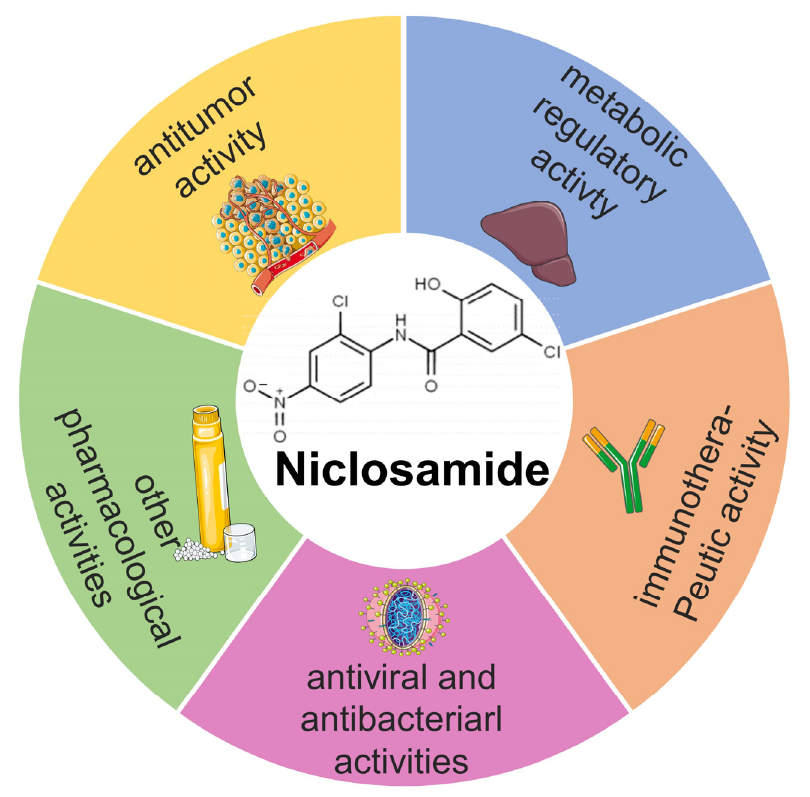
Figure 2. The multifaceted pharmacological activities of NIC in human disease and cancer.